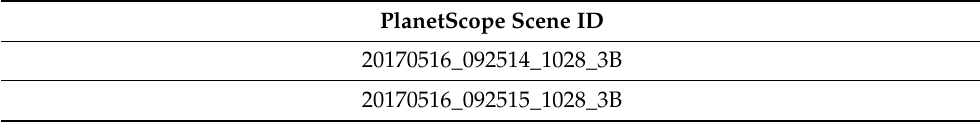
Table A5. 2 Planet Scene IDs (Dove Classic constellation) for Engadin,